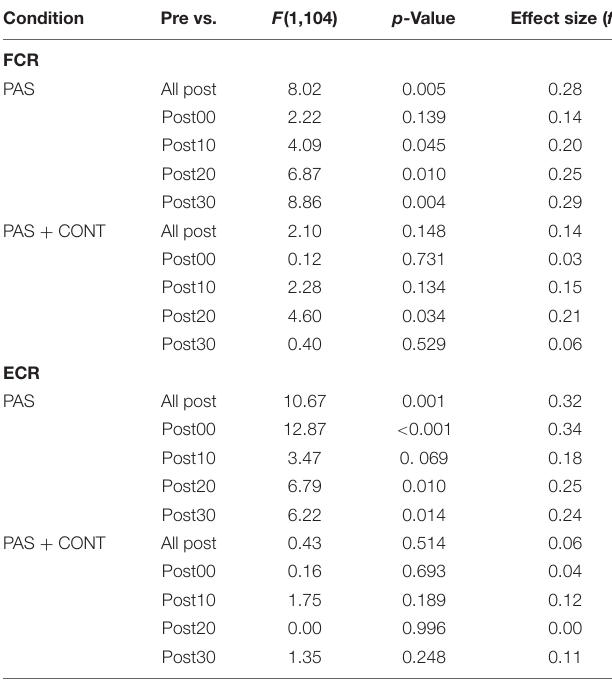
TABLE 2 | Young healthy participants: F ratios, p -values and (unbiased) effect sizes for comparisons between the MEP amplitudes obtained prior to the intervention (Pre), and (i) the pooled values obtained across all time points following the intervention, and (ii) the values obtained at each of four time points following the